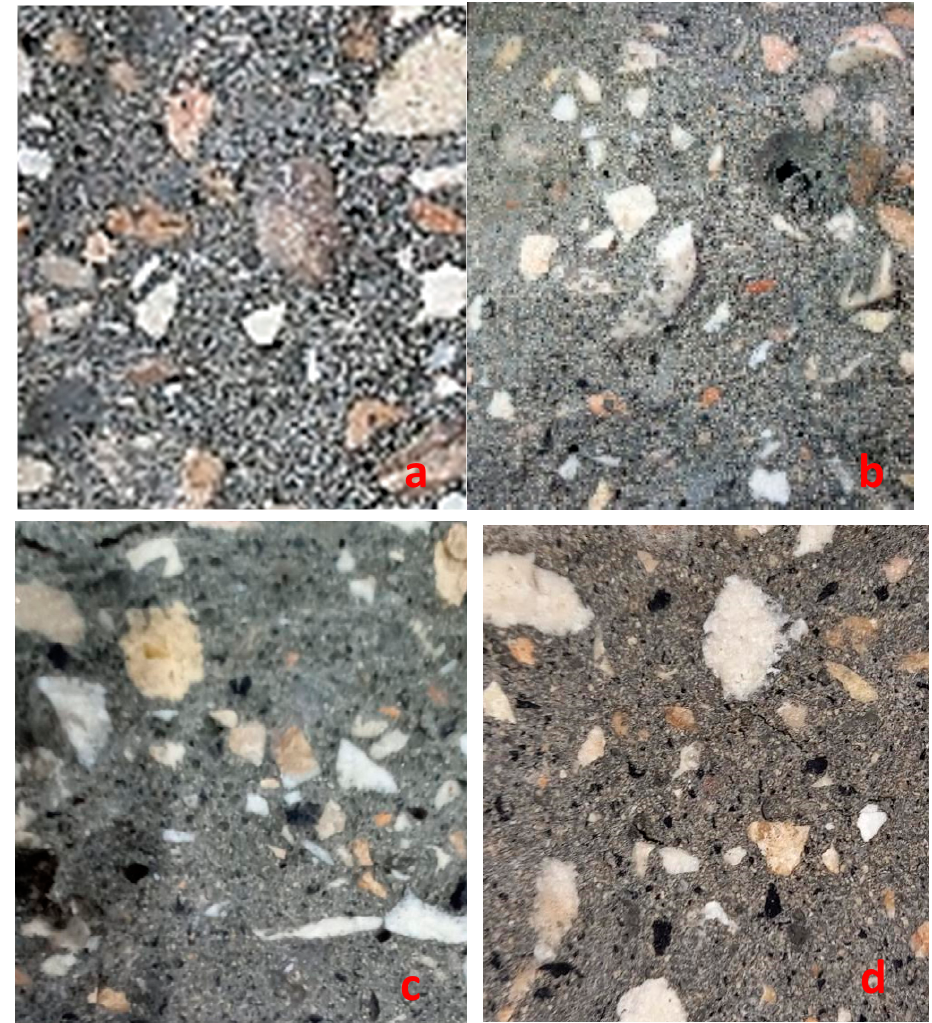
Figure 9. Microscopic views of different CR percentages: ( a ) 5% CR content; ( b ) 10% CR content; ( c ) 15% CR content; ( d ) 20% CR content.